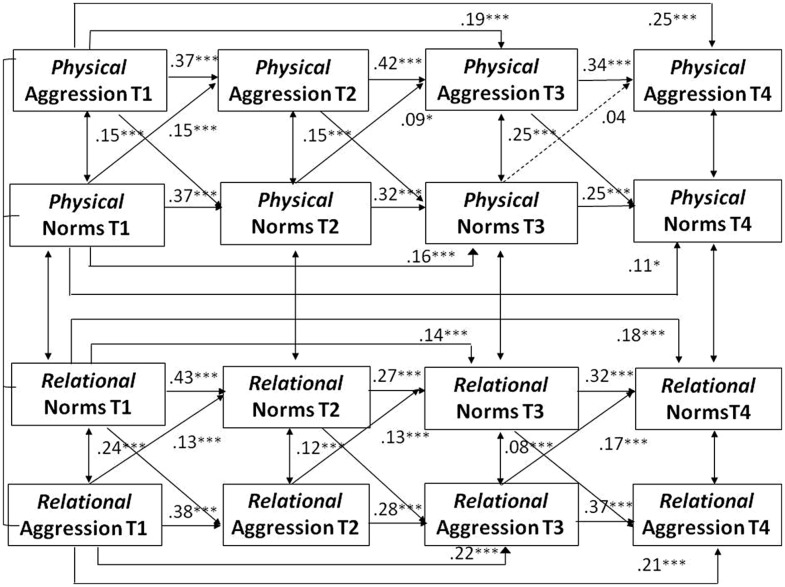
Girls’ paths of physical and relational aggression and normative approval over four data waves.
N = 962. Standardized coefficients are shown. All model variables controlled for year cohort, ethnic background, and school type. Coefficients for the cross-sectional associations included in the model are shown in Table 3. Broken lines indicate non-significant paths.